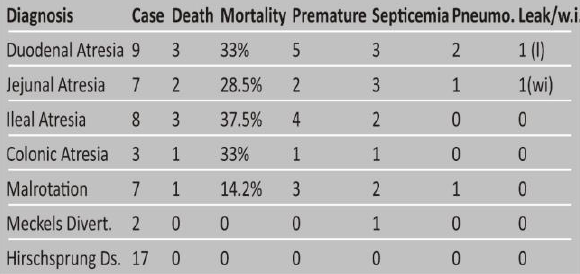
Table 1: Showing summary of study patients